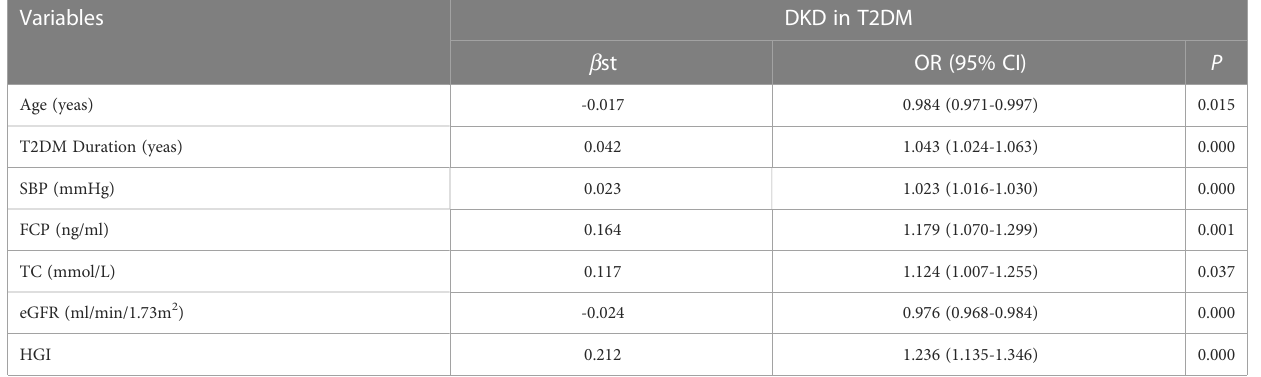
TABLE 2 Binary logistic regression analysis of risk factors for DKD in T2DM. Variables